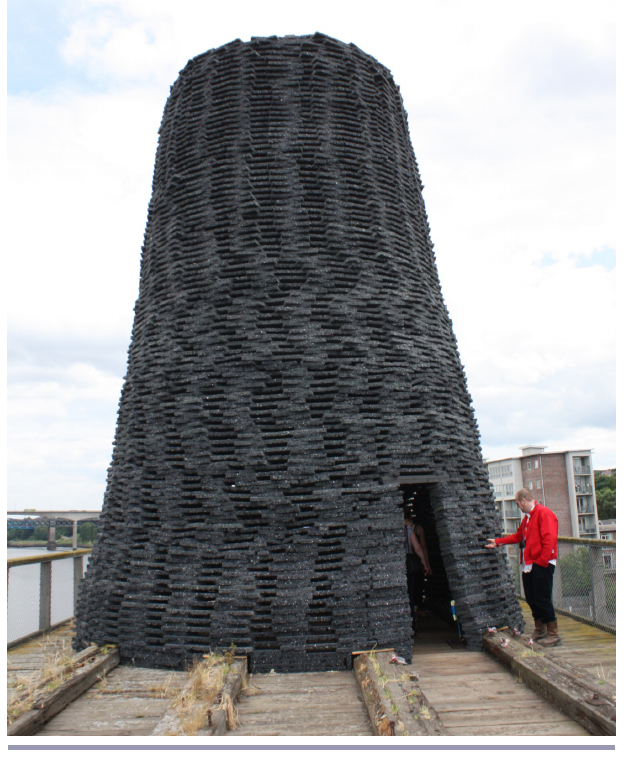
Fig. 2 . View of Cone on top of Dunston Staiths, August 2014.